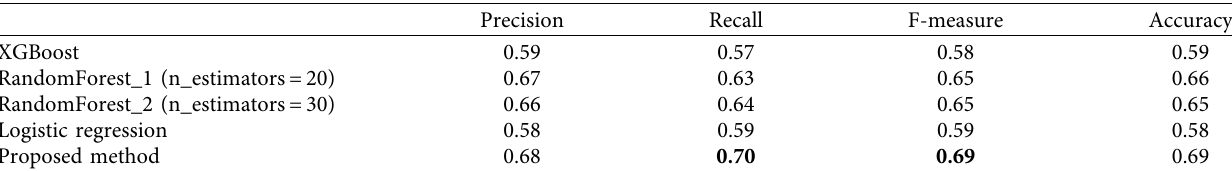
Table 4: Result for class 1 in BUP